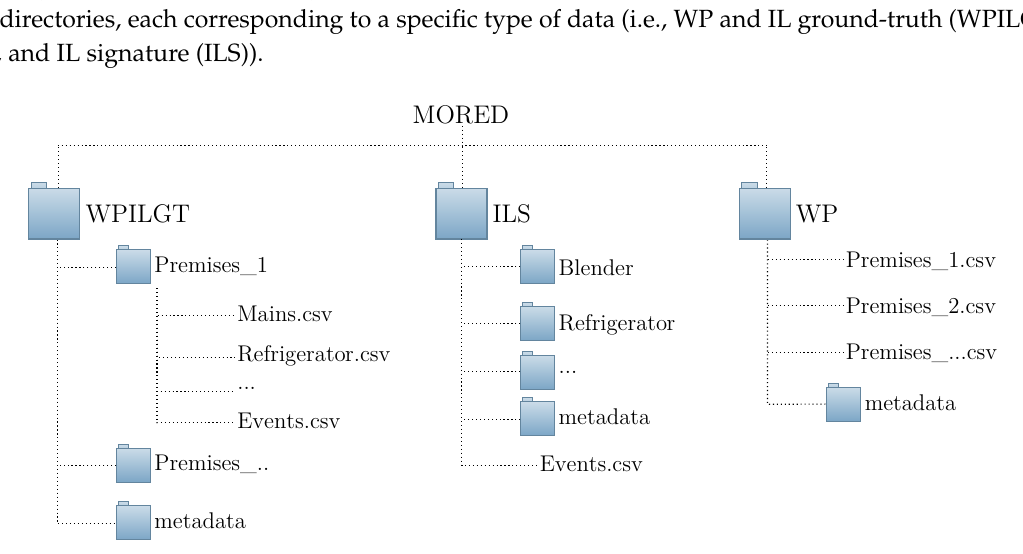
Figure 12. Tree describing the content of the MORED